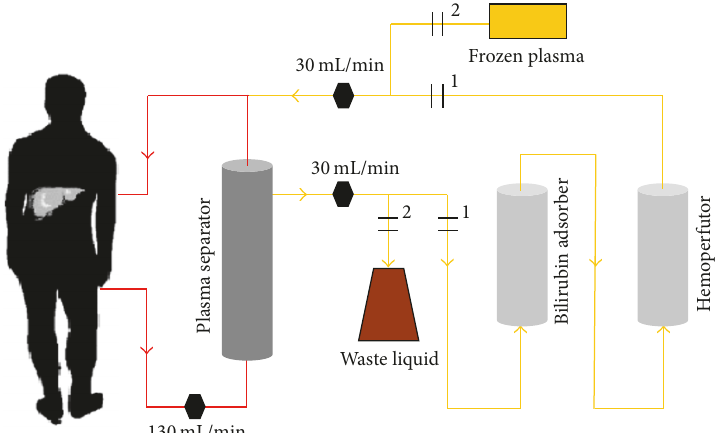
Figure 2: Schematic diagram of the double plasma molecular adsorption system (DPMAS) and plasma exchange (PE). PE ( circuit 2) is initiated immediately when DPMAS (circuit 1) is completed in this